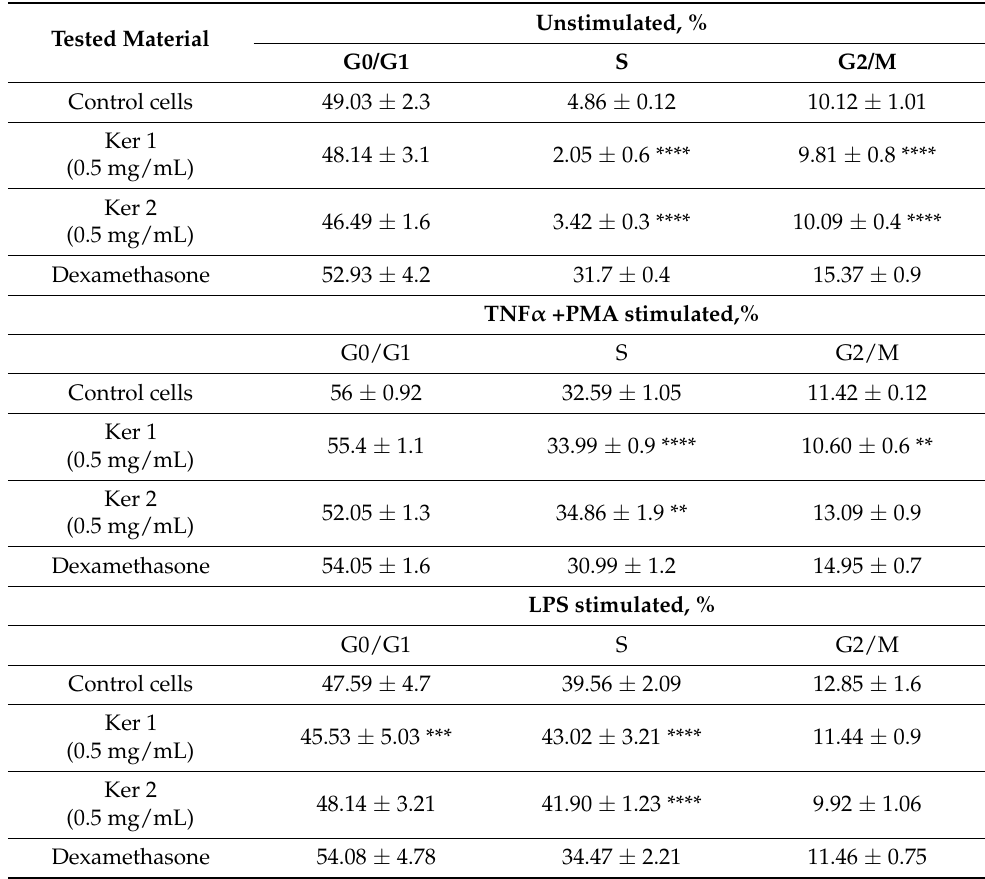
Table 6. HaCaT proliferative status expressed as cell cycle progression in normal and pro-inflammatory